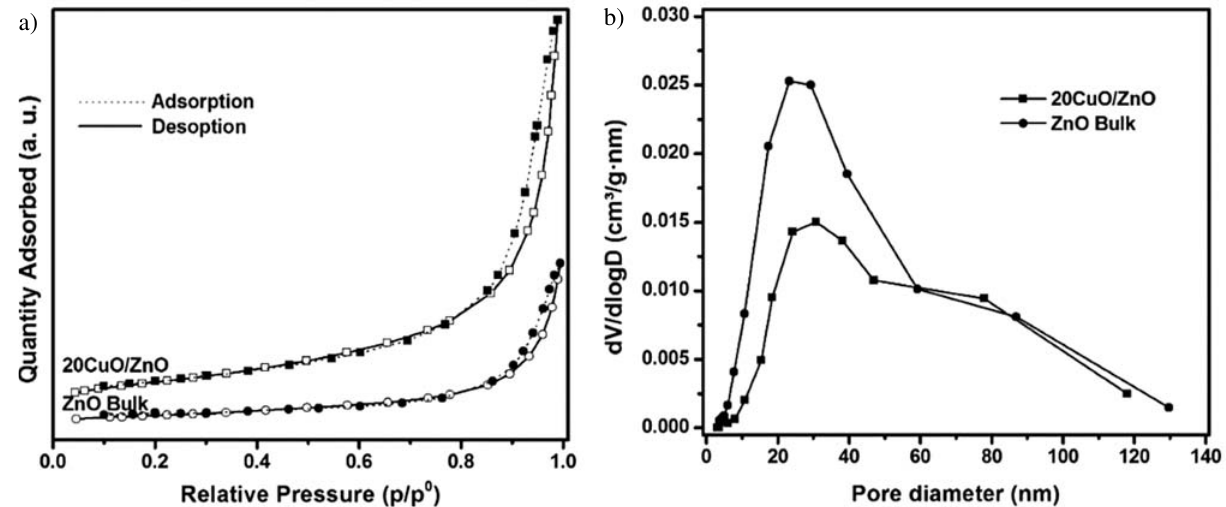
Figure 2 . (a) N adsorption/desorption isotherms, and (b) pore size distributions, of ZnO and 20CuO/ZnO samples. 2